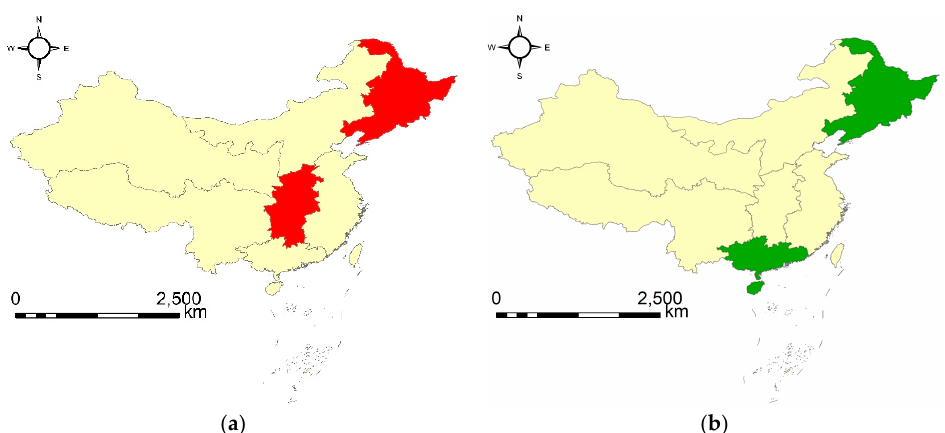
Figure 7. The discovered geographical flock patterns: ( a ) {2, 4}|[2015, 2018] (type B), and ( b ) {2, 5}|[2005, 2007] (type C). ( b ) {2, 5}|[2005, 2007] (type Table 5. The discovered geographical flock patterns based on the criterion of the high–low attribute values on the geographical region level.